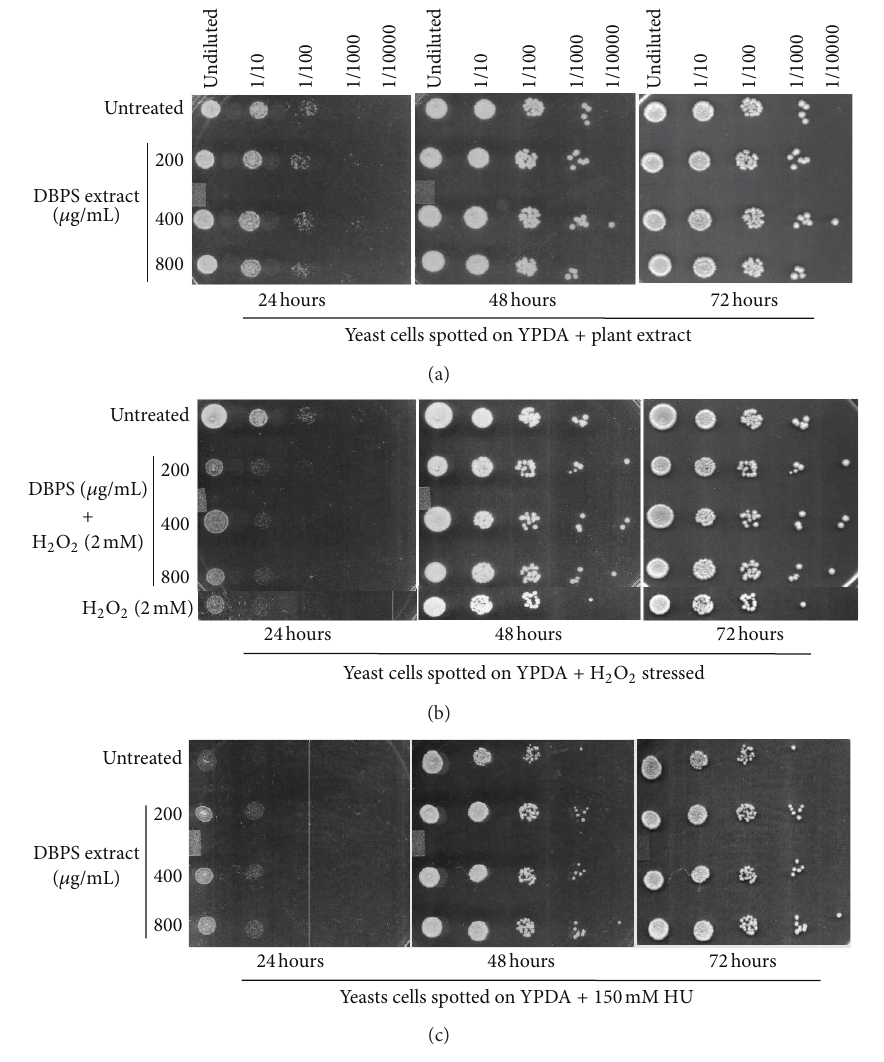
Figure 4: (a) Growth of extract treated yeast cells in comparison to untreated cells. (b) Growth of extract treated yeast cells in presence of stressing agent (H 2 O 2 ) in comparison to untreated cells. (c) Growth of yeast cells on Hydroxyurea (HU) laden YPDA plates with and without treatment of